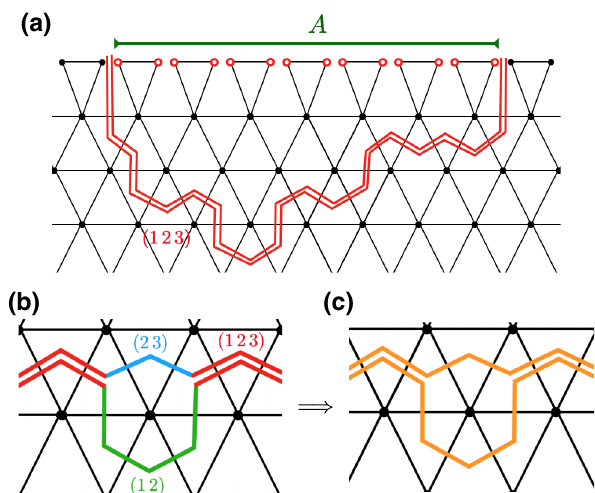
FIG. 12. S 3 lattice magnet with randomly located measure- ments. The leading contribution to the replicated description of the von Neumann entanglement with n = 3 replicas comes from paths taken by the domain wall ( 1 2 3 ) ∈ S 3 through the bulk of the lattice magnet as shown in (a). In the large- q limit consid- ered in the text, all such paths appear with the same weight. The leading correction to this behavior comes from the “splitting” of this domain wall, shown in (b), while all other processes are fur- ther parametrically suppressed in powers of q − 1 . The replicated description may be thought of as a pair of labeled paths with an attractive interaction